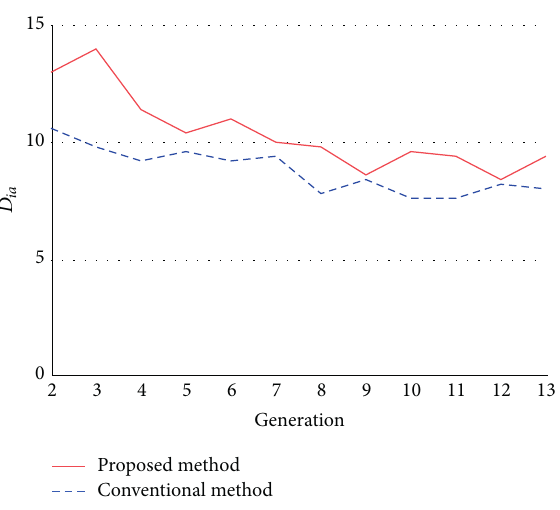
Figure 18: Value of 𝐷 𝑖𝑎 in each generation. The results of the proposed method are depicted by the solid red line and those of the conventional method by the dotted blue lines. The number of landscapes is the number of trials by each